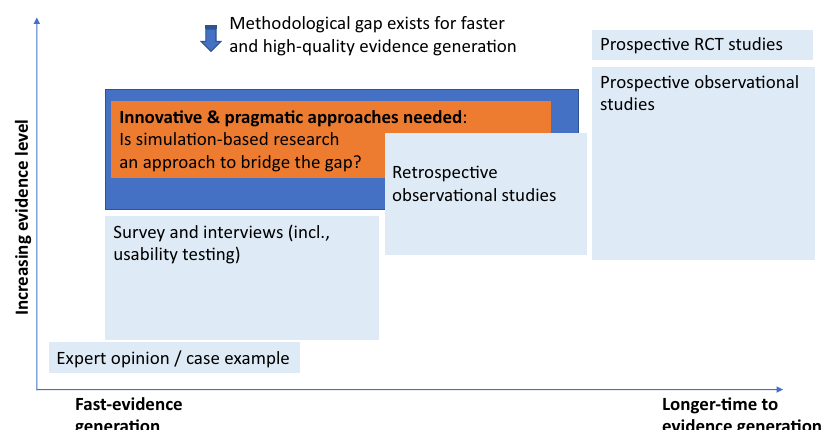
Fig. 1 Existing approaches for health digital solution evaluation, current methodological gap and emerging innovative pragmatic approaches to fi ll such gap. Note, the position of each methodology is meant to be illustrative and re fl ecting general